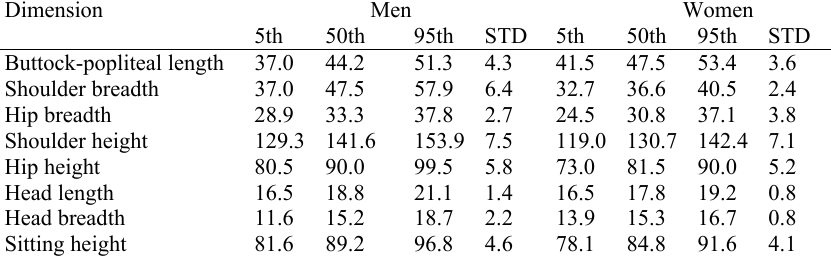
Table 4. Anthropometric dimensions for Turkish adults